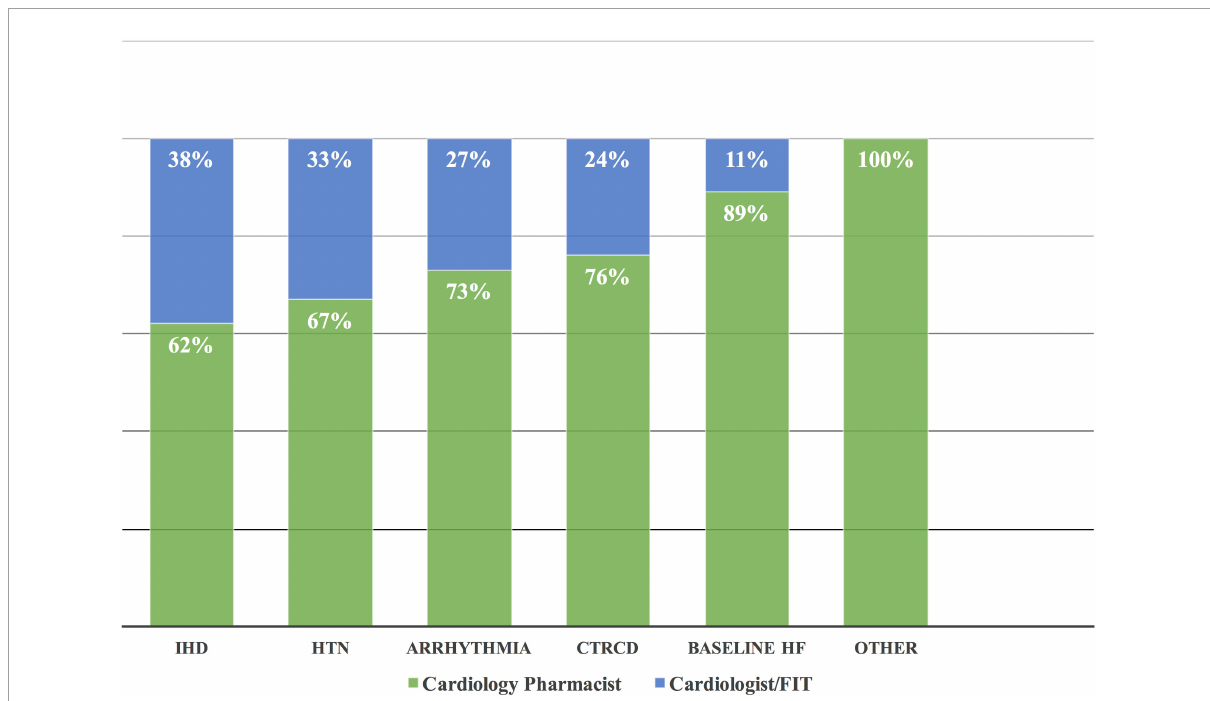
FIGURE6 Complementary drug interventions in different CVRF/CVD. Based on the complementary approach, most of the drug intervention by the cardiology pharmacist was in patients with baseline HF followed by CTRCD. Others included transient ischemic attack, hypertriglyceridemia, and right atrial thrombus. CVD, cardiovascular disease; CTRCD, cancer therapy-related cardiac dysfunction; CVRF, cardiovascular risk factor; HF, heart failure; HTN, hypertension; IHD, ischemic heart disease.